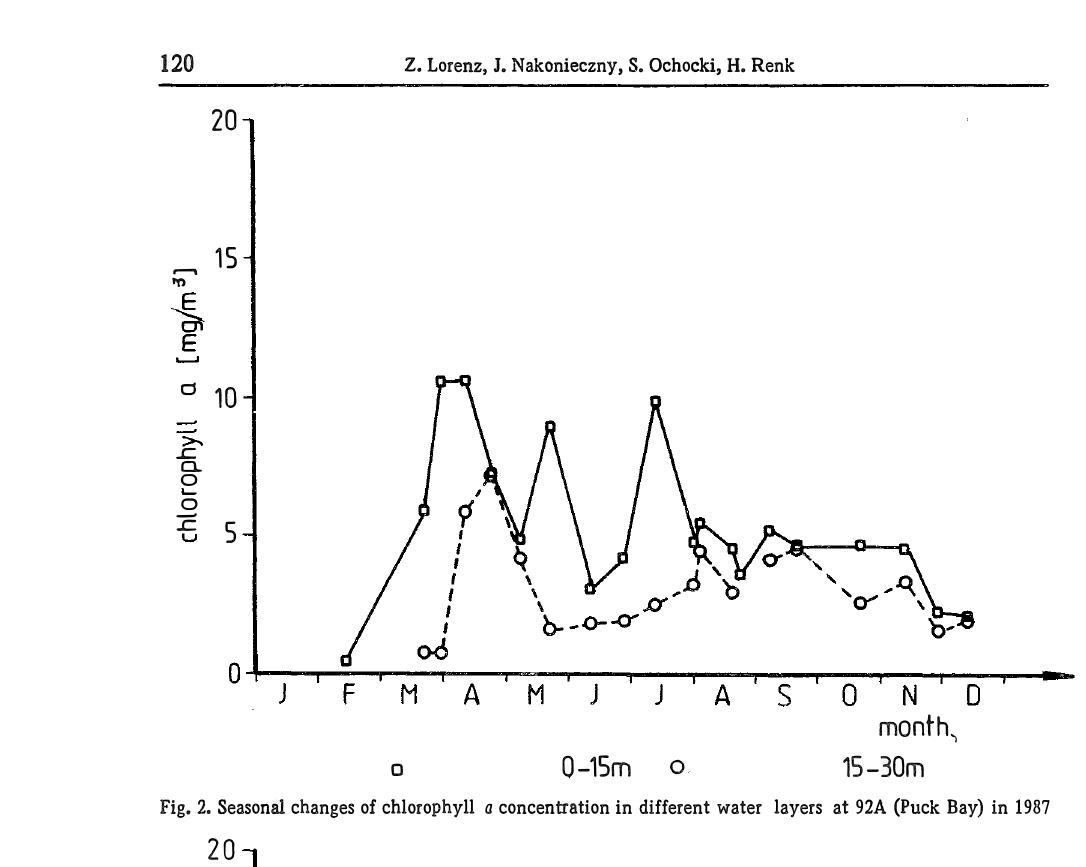
Fig. 2. Seasonal changes of chlorophyll a concentration in different water layers at 92A (Puck Bay) in 1987